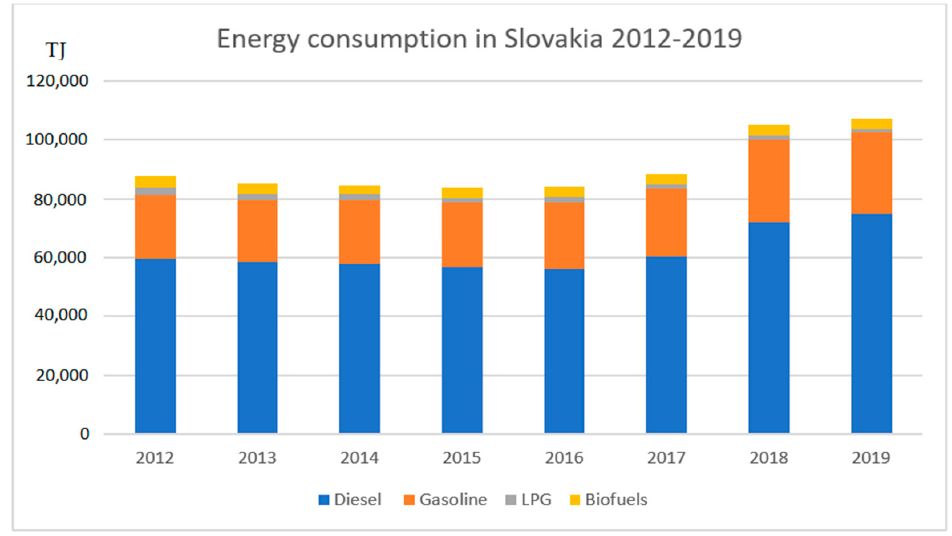
Figure 4. Energy consumption in road transport in the Slovak Republic, 2012–2019 [12].